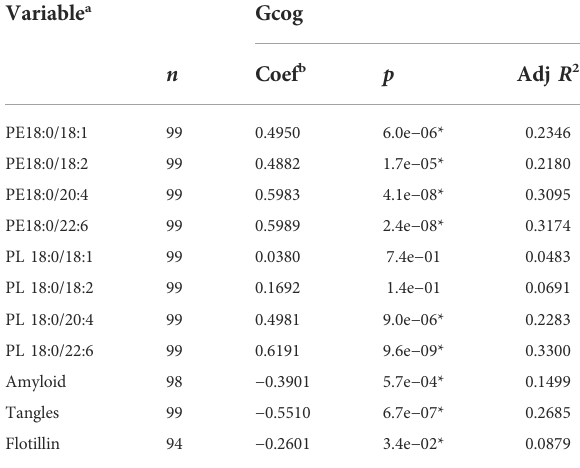
TABLE 3 Association of clinical and biological variables with